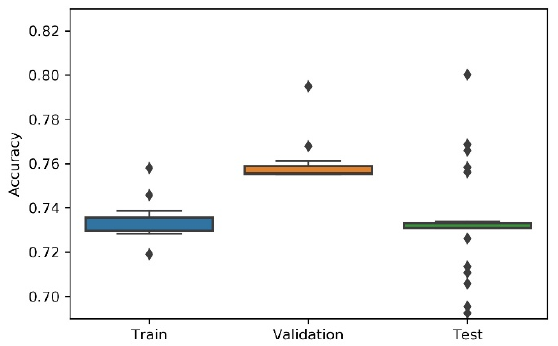
Figure 9. Experiment’s performance for Approach A3 (Hyperband) accuracy (in %).